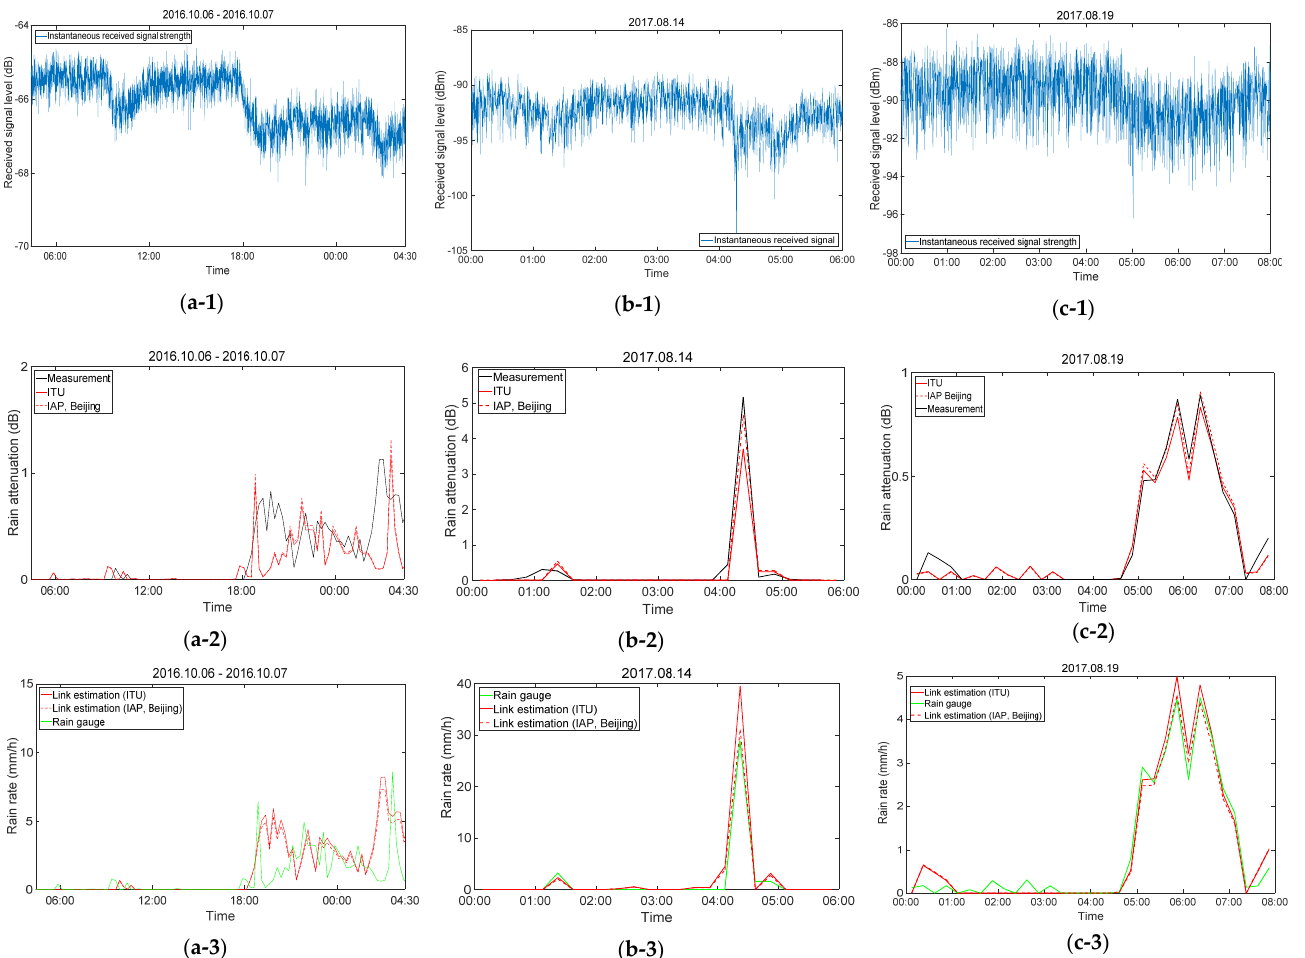
Figure 6. ( a-1 , b-1 , c-1 ) Link instantaneous signal level on 6–7 October 2016, 14 August 2017, and 19 August 2017; ( a-2 , b-2 , c-2 ) The measured average rain attenuation per 15 min, the rain attenuation based on the ITU model and rain attenuation calculated using locally derived coefficients on 6–7 October 2016, 14 August 2017, and 19 August 2017; ( a-3 , b-3 , c-3 ) The link retrieved rainfall rate based on coefficients ( a , b ) from the ITU model and the derived ( a , b ) from local measurements, compared to the rain gauge measurement on 6–7 October 2016, 14 August 2017 and 19 August 2017. (Note the signal measurement is discussed in [48] but based on ( a , b ) coefficients in ITU-R P.838 document, the analysis in this paper shows the derived coefficients achieved an improved rainfall rate estimation.) Table 3. Correlation and mean relative error of the rainfall rate recorded by a rain gauge and es- timated rainfall rate based on the power law coefficients from the ITU ( R ITU ) or locally derived co- efficients at IAP, CAS in Beijing ( R IAP ).